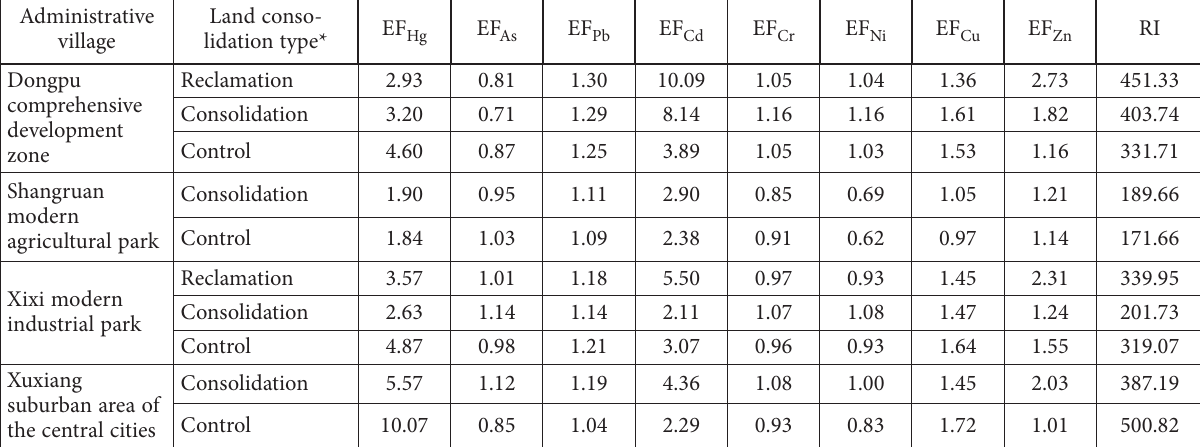
Table 4. Soil heavy metal contamination in the study areas